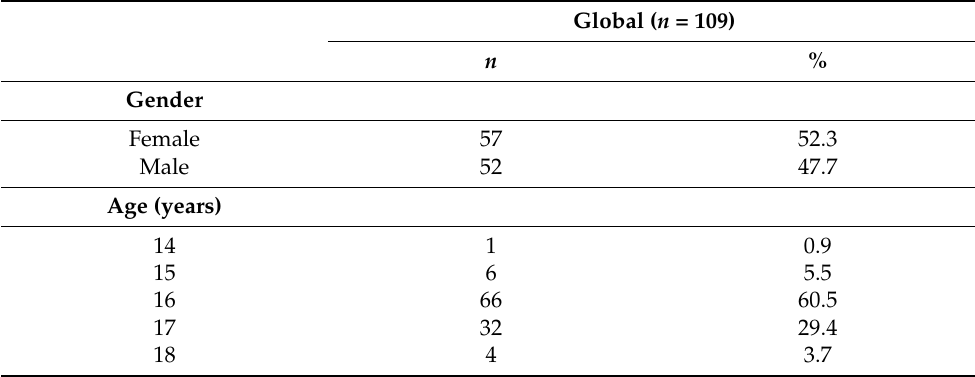
Table 1. Distribution of absolute ( n ) and relative frequencies (%) from adolescents according to their gender and age.